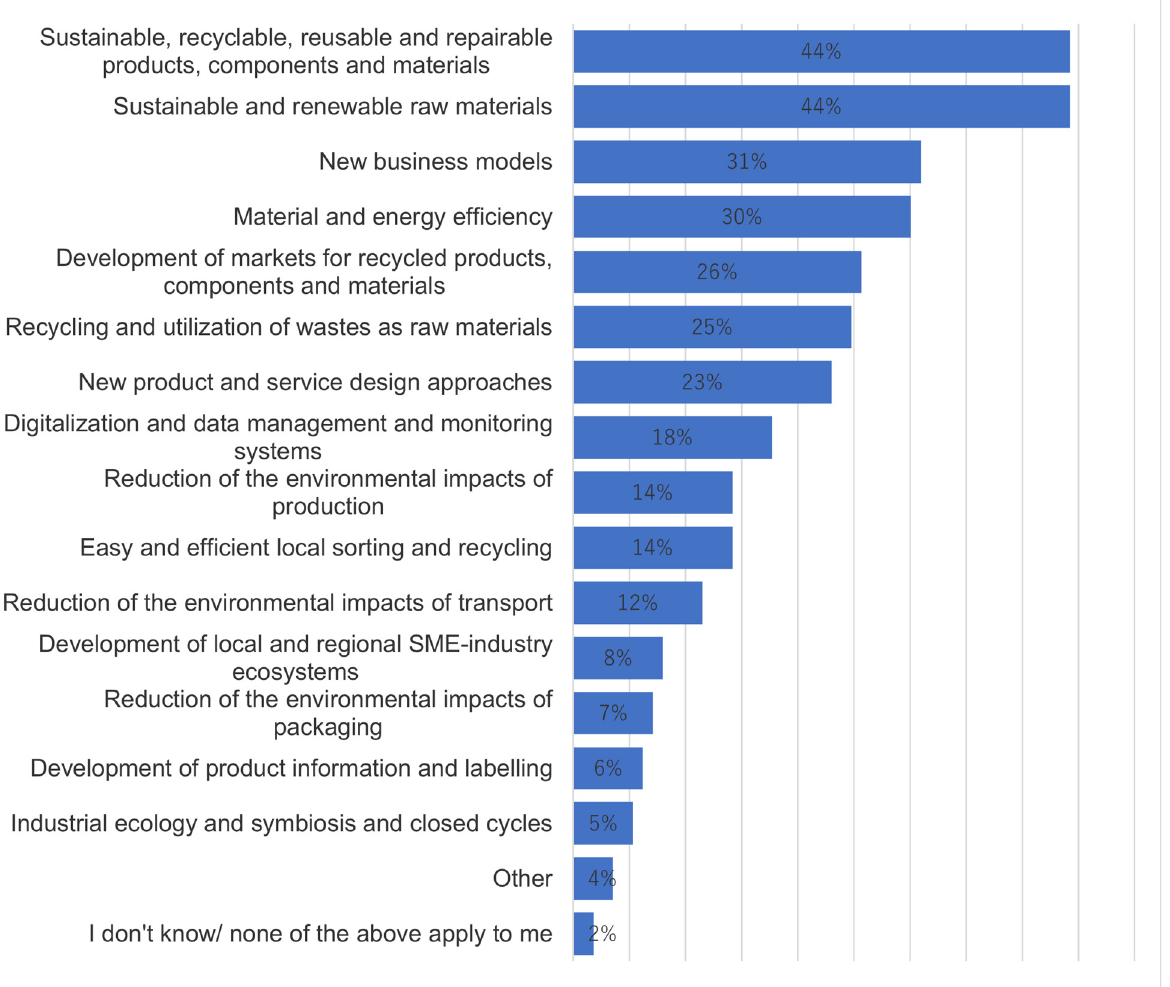
Figure 10. The most potential areas to create significant circular economy innovations.